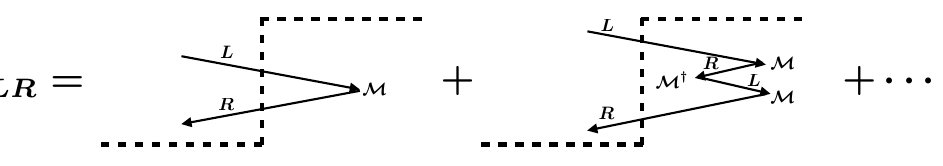
Figure 4 . The schematic description of the perturbative calculation for the reflection coefficient R LR . The dotted line shows the bubble wall configuration. M and M † represent the mass matrix operator and its Hermitian conjugate. The first and second terms on the right hand side correspond to E (1) (0) and E (3) (0) , R R